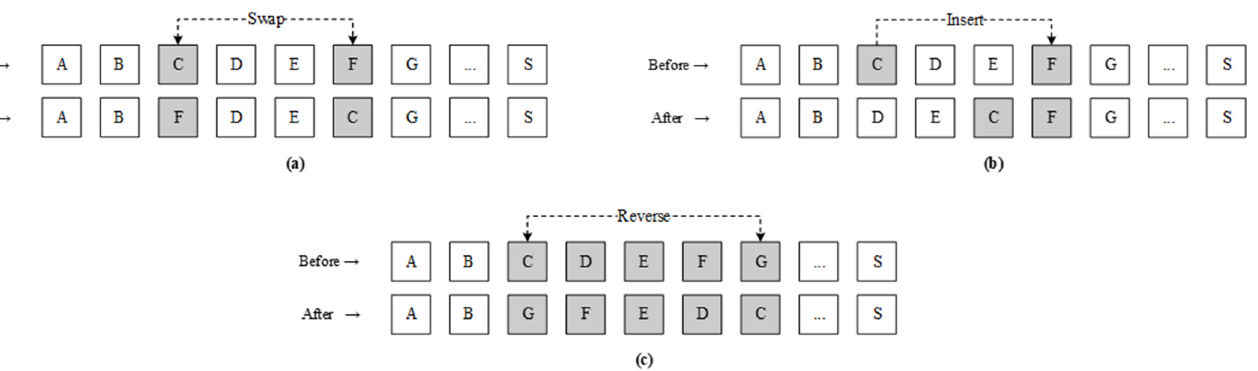
Table 11. Profit volumes, total closeness rating, and execution time for the three algorithms . PrefixSpan and MBHS Iteration